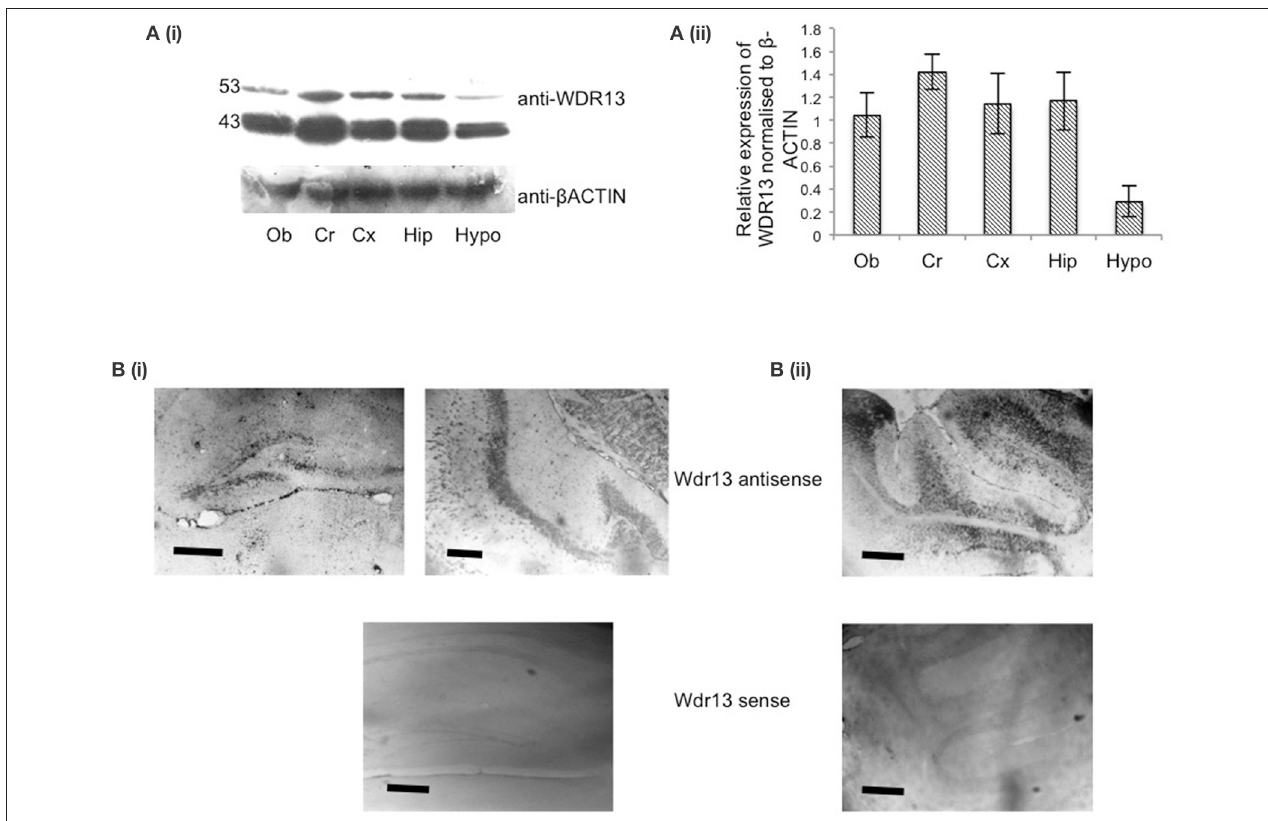
FIGURE 1 | (Ai) Representative blot for western analysis using antibody against WDR13 in different regions of the mice brain at 2 months age (Ob, Olfactory bulb; Cr, Cerebellum; Cx, Cortex; hip, Hippocampus; Hypo, Hypothalamus). (Aii) Relative quantification of expression of WDR13 in different brain regions ( n = 3). Data represented as ± SD (B) . RNA- in situ hybridization using full length anti- Wdr13 probe showing localization in (i) Hippocampus and (ii) Cerebellum. Top panel(s) depicts sections probed using Wdr13 antisense probe and bottom panel(s) depict sections probed using Wdr13 sense probe. Scale: 100 µ